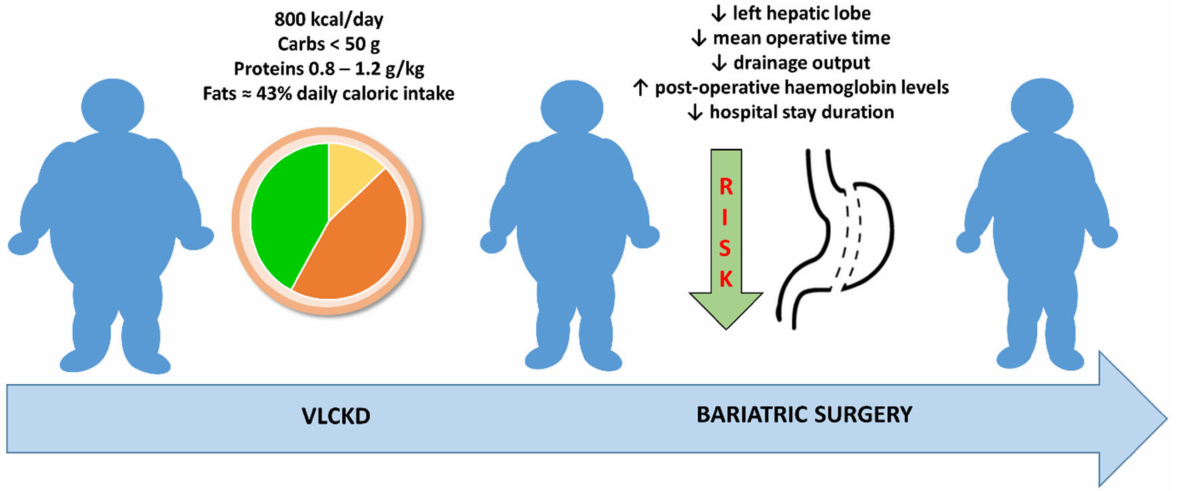
Figure 2. A very-low-calorie ketogenic diet can be a valid tool to induce weight loss before bariatric surgery, leading to the reduction of surgical